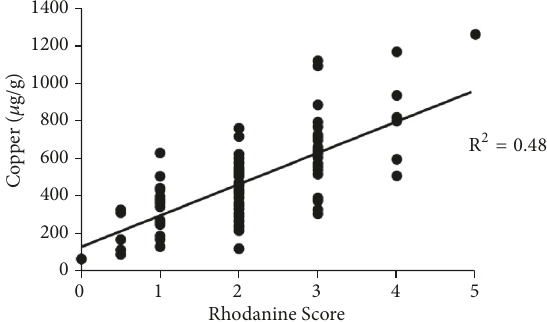
Figure 3: Correlation of quantitative copper concentrations ( 𝜇 g/g) and rhodanine scores